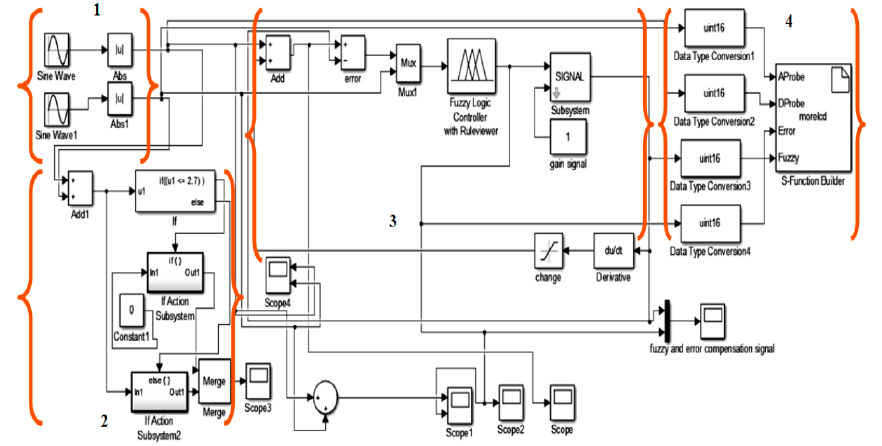
Figure 4. The Simulink Block Diagram Model for ECECT. (1) Input source, (2) Conditioning process, (3) Fuzzy logic process and feedback, (4) Output display.